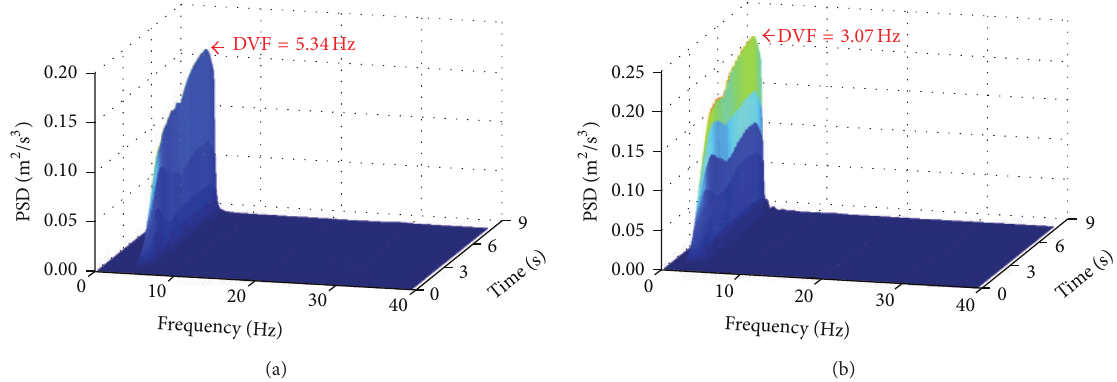
Figure 4: PSD of acceleration of bridge girder midpoint. (a) Vertical. (b) Lateral.